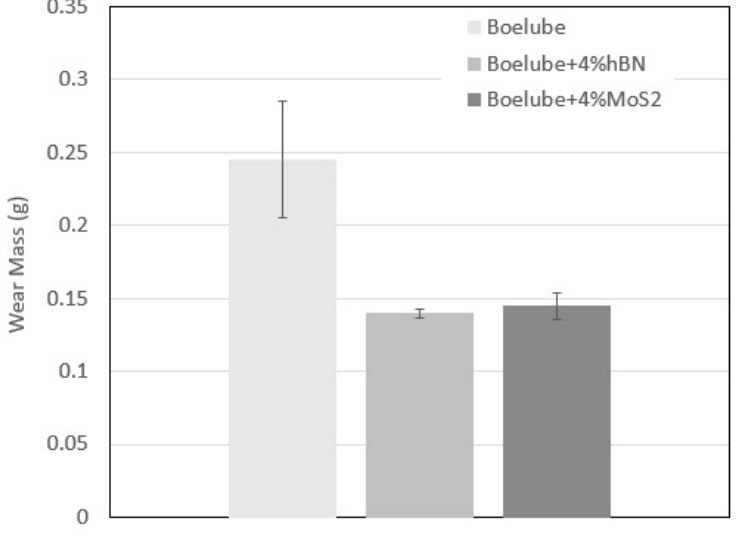
Figure 10. Wear of titanium lower balls.